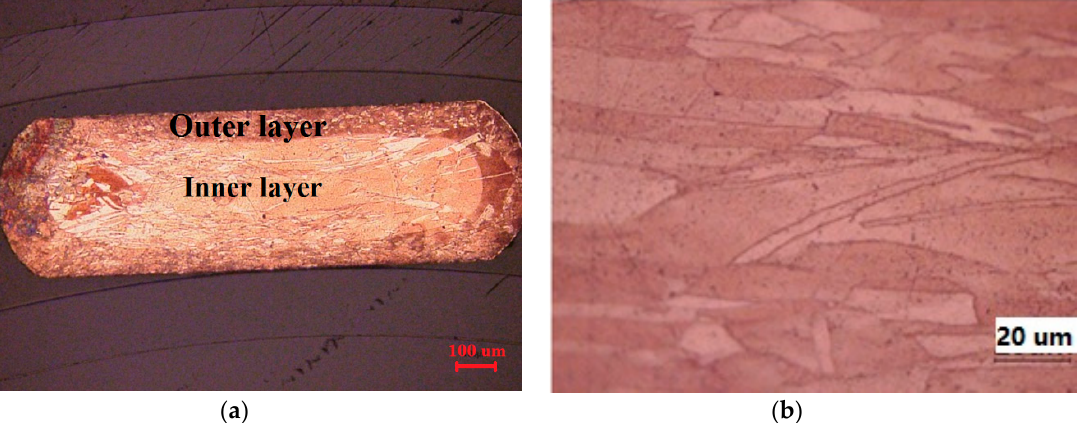
Figure 9. Microstructure of rolled wire after micro-rolling. ( a ) Whole rolled wire; ( b ) inner layer.